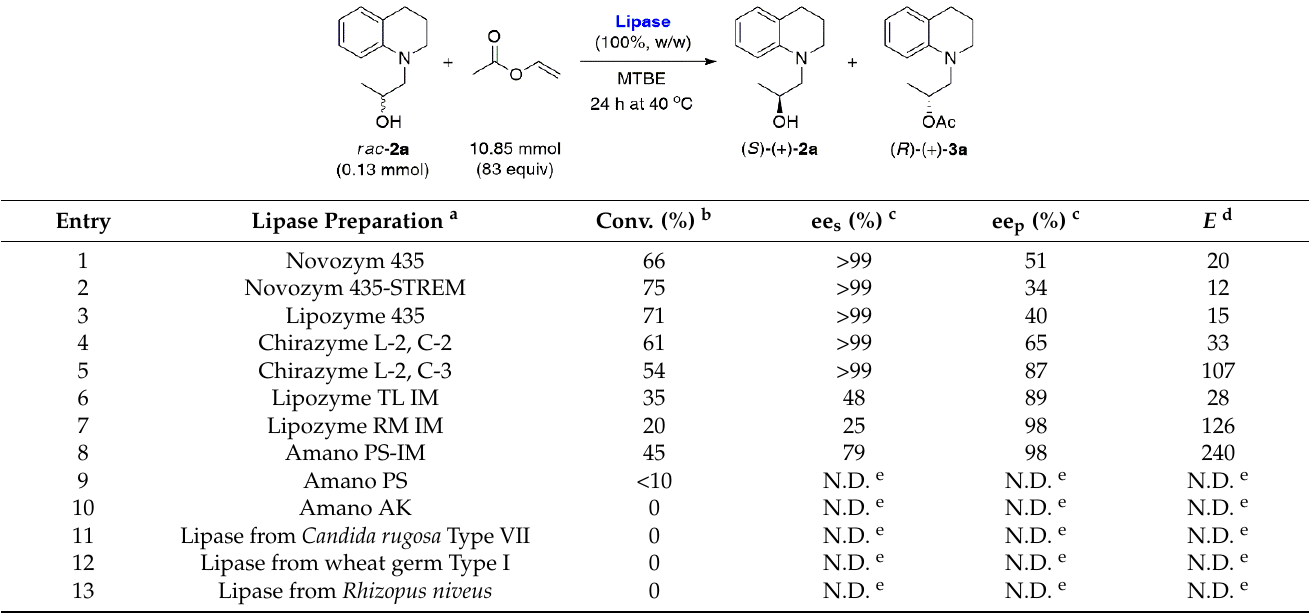
Table 1. Lipase screening for lipase-catalyzed KR of rac - 2a with vinyl acetate in MTBE.